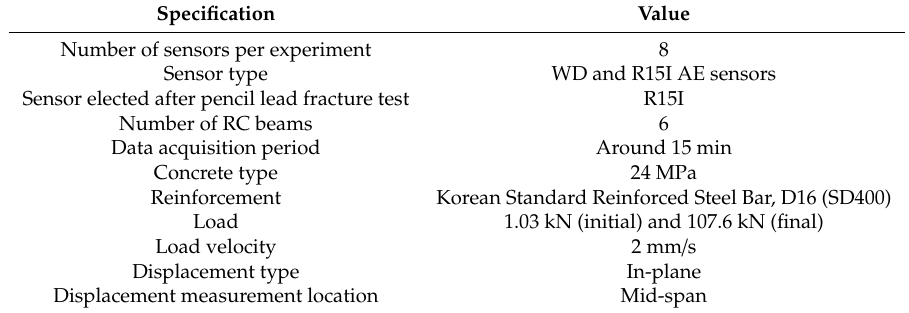
Table 1. Parameters and specifications of the conducted experiments. RC: reinforced